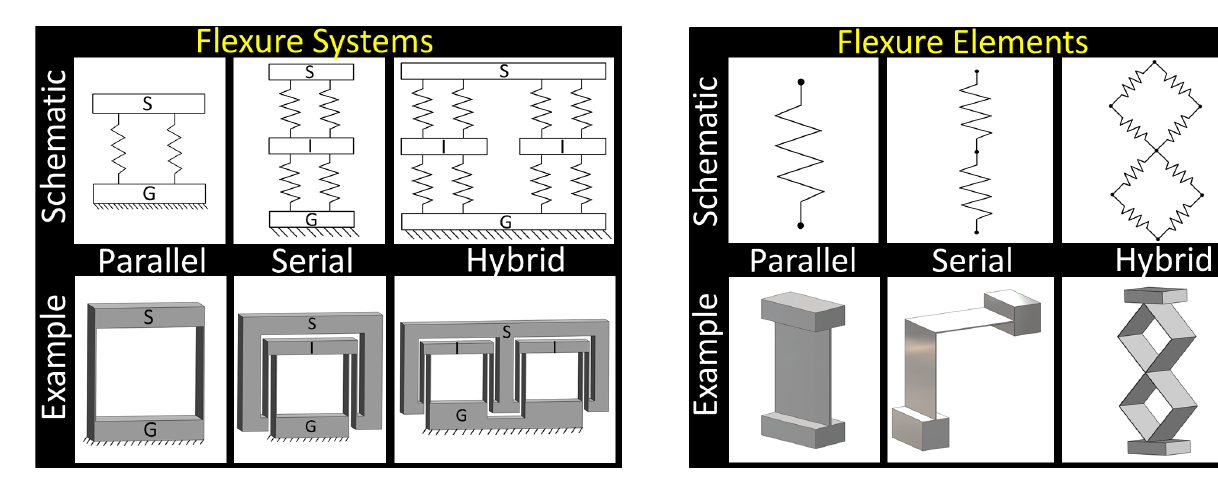
Figure 1. Three kinds of flexure systems – parallel, serial, and hy- brid.